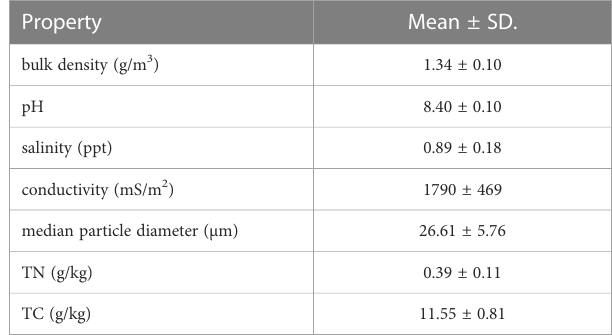
TABLE 1 Properties of mud used in the study. Property Mean ±